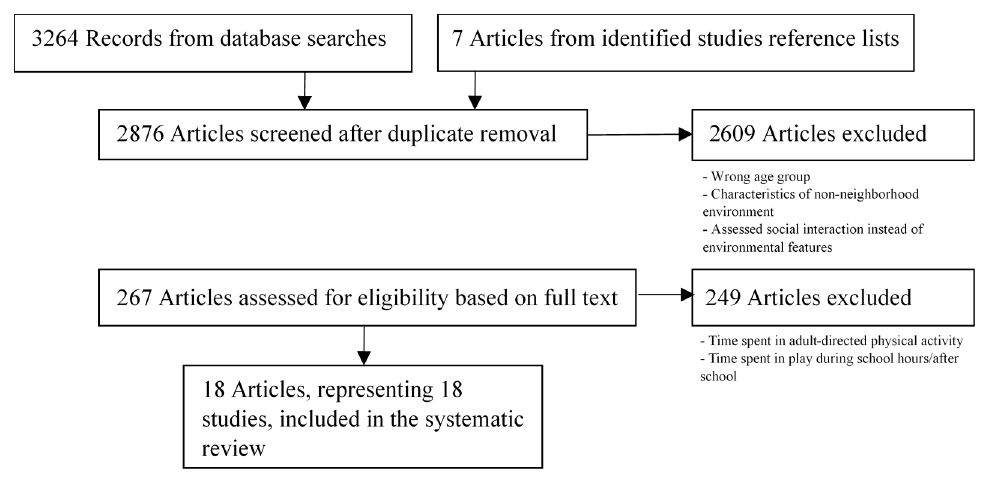
Figure 1. Study search strategy.